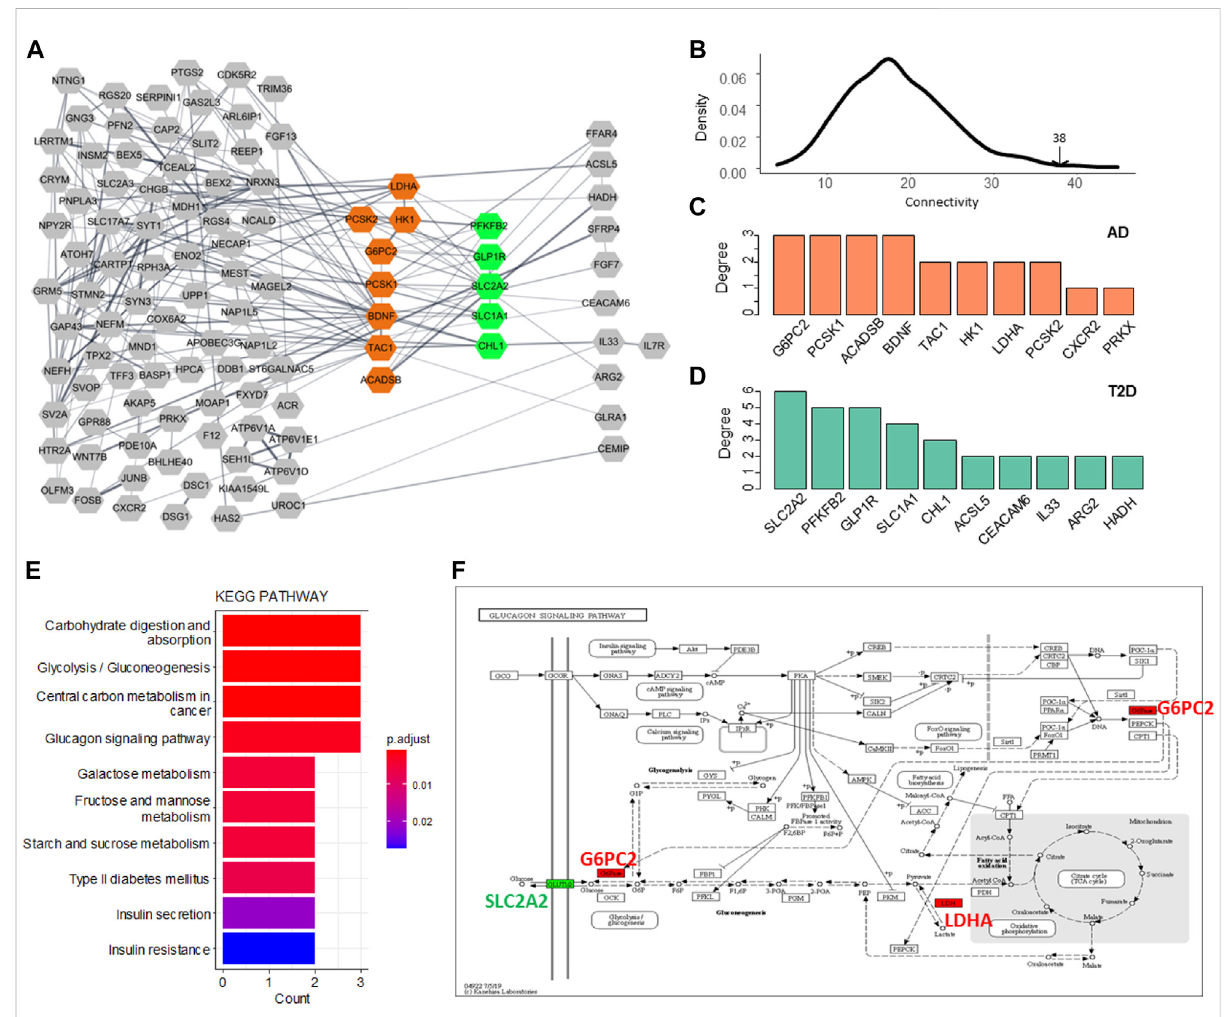
FIGURE 4 Network analysisof theAD and T2DM DEGs. (A) PPI network ofthe AD and T2DM DEGs. Node represents DEG while edge indicates interaction between a pair of DEGs. The hub genes of AD and T2DM are highlighted in orange and green, respectively. (B) Distribution of the connectivity between simulated data. (C , D) Hub genes with top network degree for AD and T2DM, respectively. (E) Enriched KEGG pathways of the13 hub DEGs. (F) Glucagon signaling pathway. G6PC2 and LDHA (AD DEGs) are colored in red and SLC2A2 (T2DM DEG) is colored in